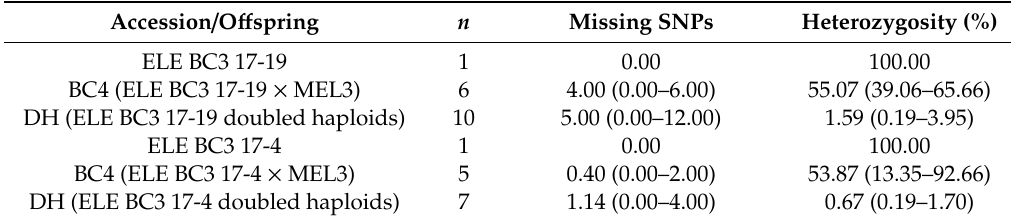
Figure 7. Calluses obtained two months after the culture of anthers in medium R applying the Cb protocol ( A , B ). By subculturing these calluses in E6 medium, shoot induction was achieved after approximately one month of induction in this medium ( C ) and finally the seedlings can be isolated ( D ). Table 5. SPET mass genotyping results shown as a percentage of heterozygosity (mean and range) calculated based on the genotyping of 532 single nucleotide polymorphism (SNP) positions in the accessions derived from materials BC3 17-19 and BC3 17-4. Among these materials, we find backcrossings with the cultivated parental MEL3 (BC4) and plants obtained from the application of the E6 (DH) protocol. The number of positions SNPs evaluated and those that were not found in the specific accessions are